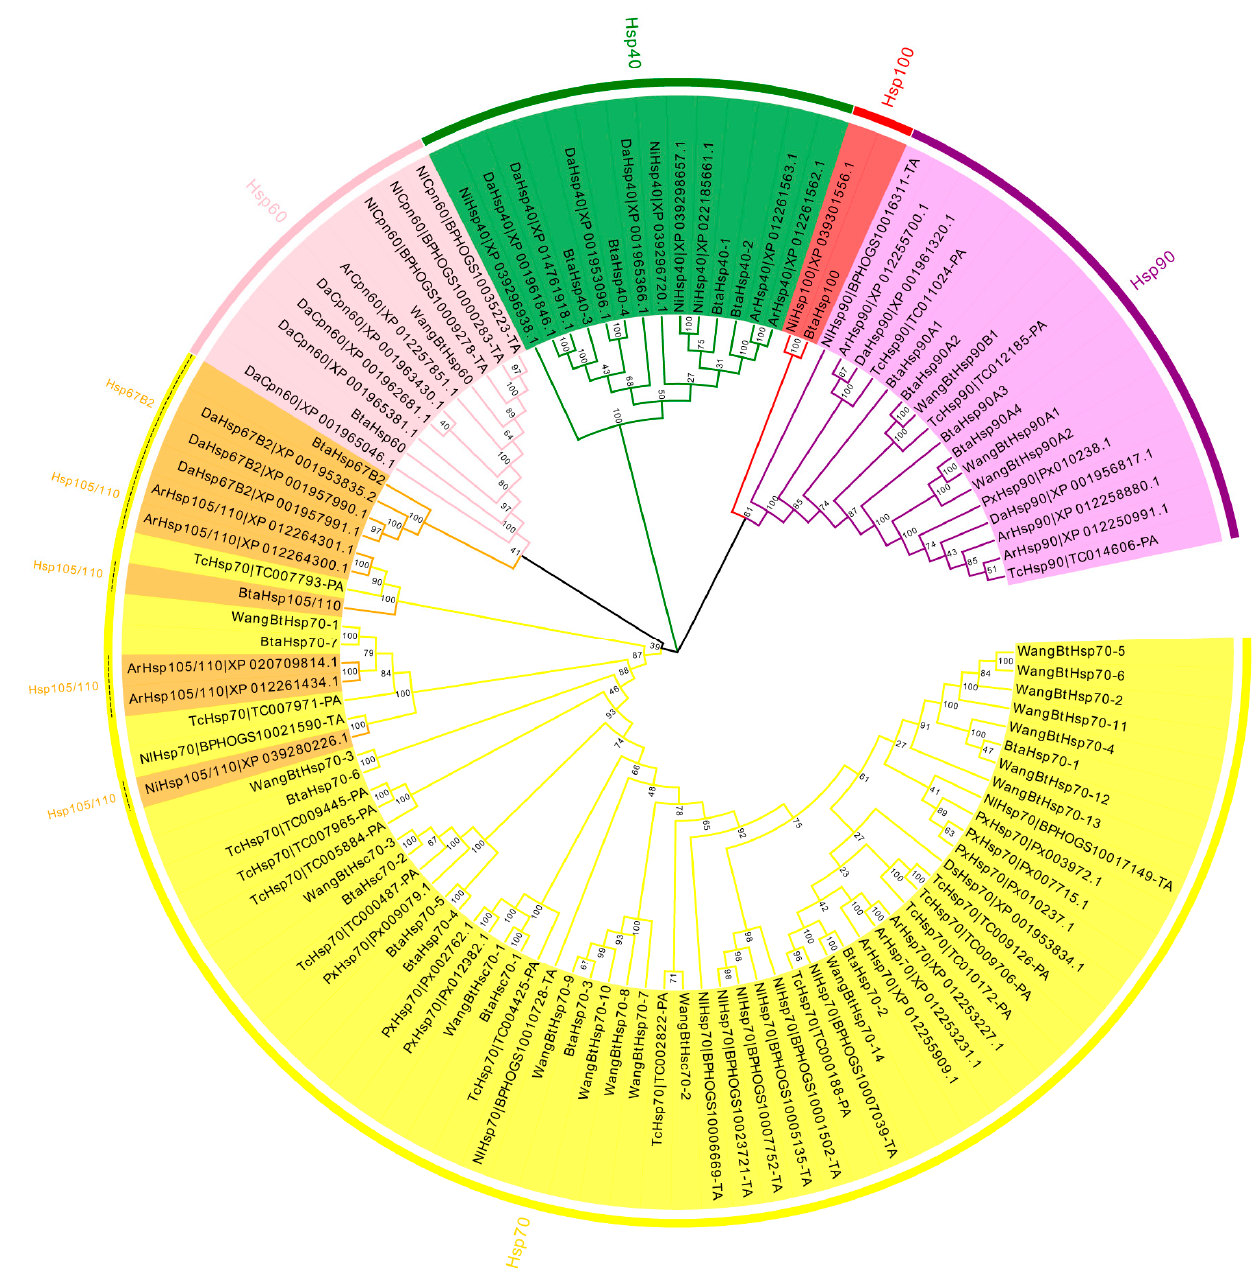
Figure 1. Phylogenetic relationships of Hsp from Bemisia tabaci , Plutella xylostella , Tribolium castaneum , Drosophila ananassae , Athalia rosae , and Nilaparvata lugens . The unrooted phylogenetic tree was constructed using MEGA7 by the neighbor-joining method and the bootstrap test was set as 1000 replicates. The colored shadow represents the different BtaHsp families.